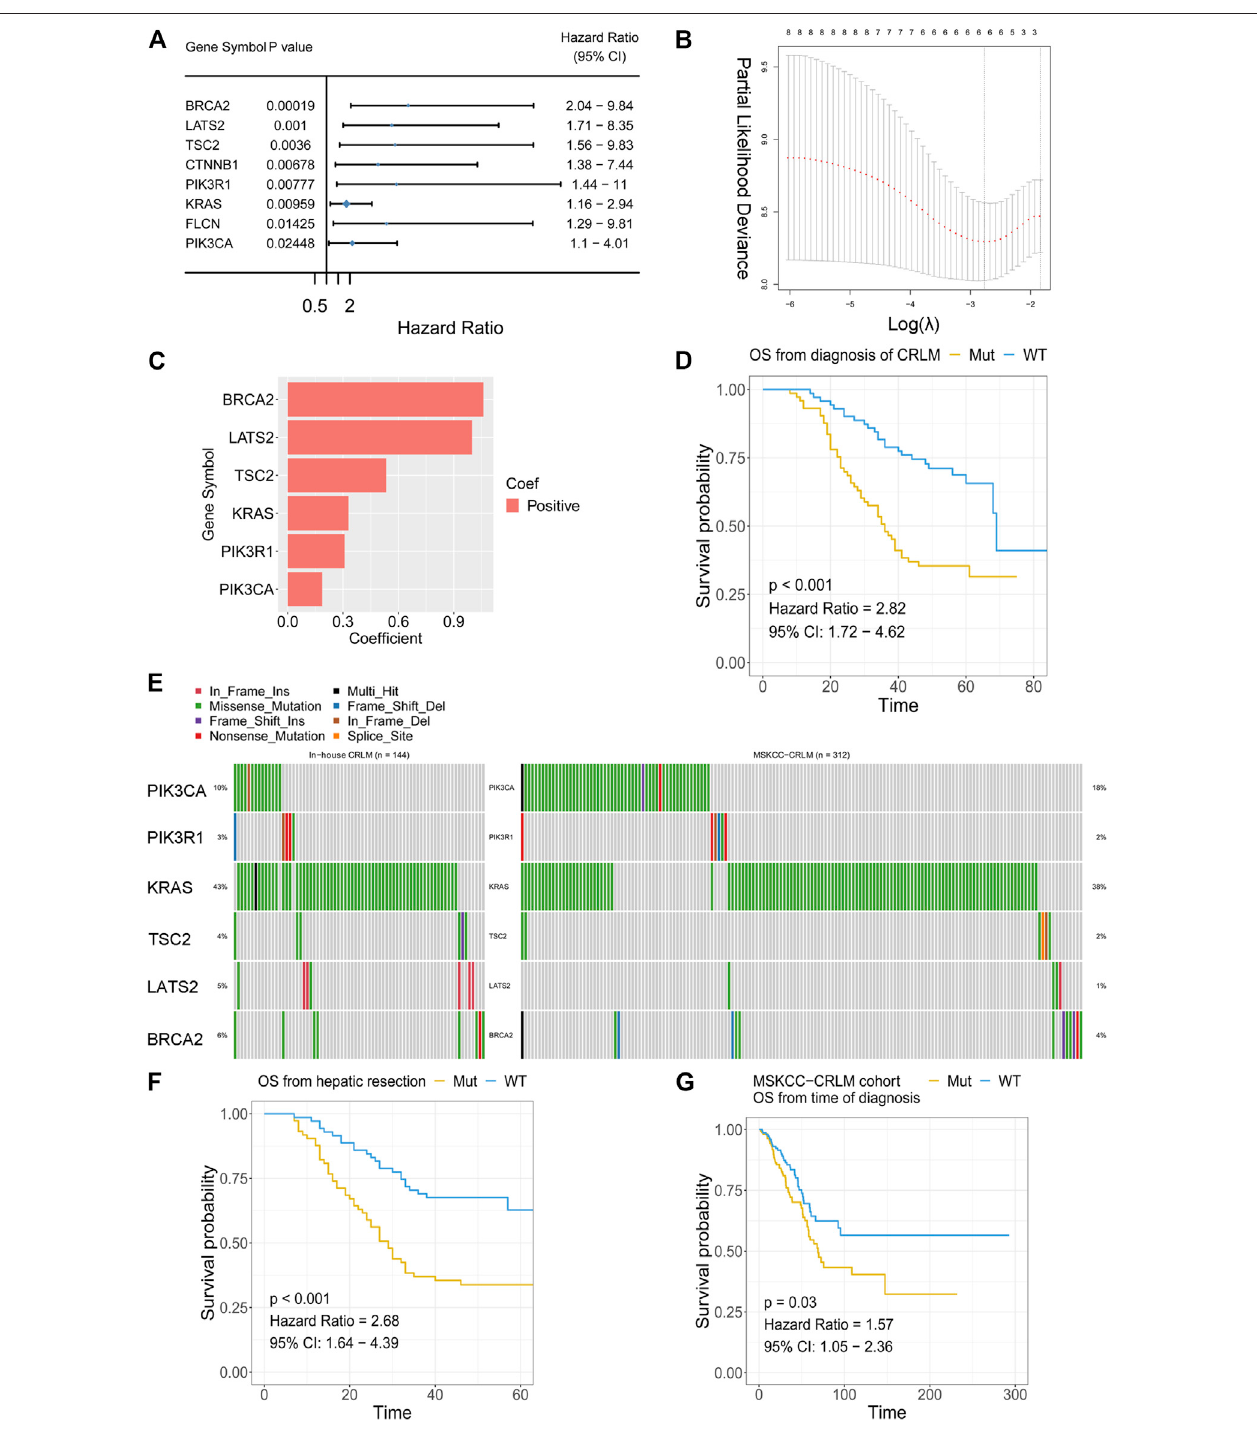
FIGURE 4 | Mutation-based gene-signature construction (A) Selection of prognostic gene alterations (B) LASSO Cox regression feature selection (C) Distribution of thecoef fi cients ofthe established gene signature (D) Patients with at least one genemutationexhibited worse OSfrom the time ofdiagnosis ofCRLM than those with nogenemutationsinthein-houseCRLMcohort (E) Oncoplotshowingmutationtypesinthein-houseCRLMcohort (F) Patientswithatleastonegenemutationexhibited worse OS after hepatic resection than those with no gene mutations in the in-house CRLM cohort (G) The external MSKCC-CRLM cohort validated the ef fi cacy of the mutation-based gene signature. LASSO: least absolute shrinkage and selection operator; OS: overall survival; CRLM: colorectal liver metastases.